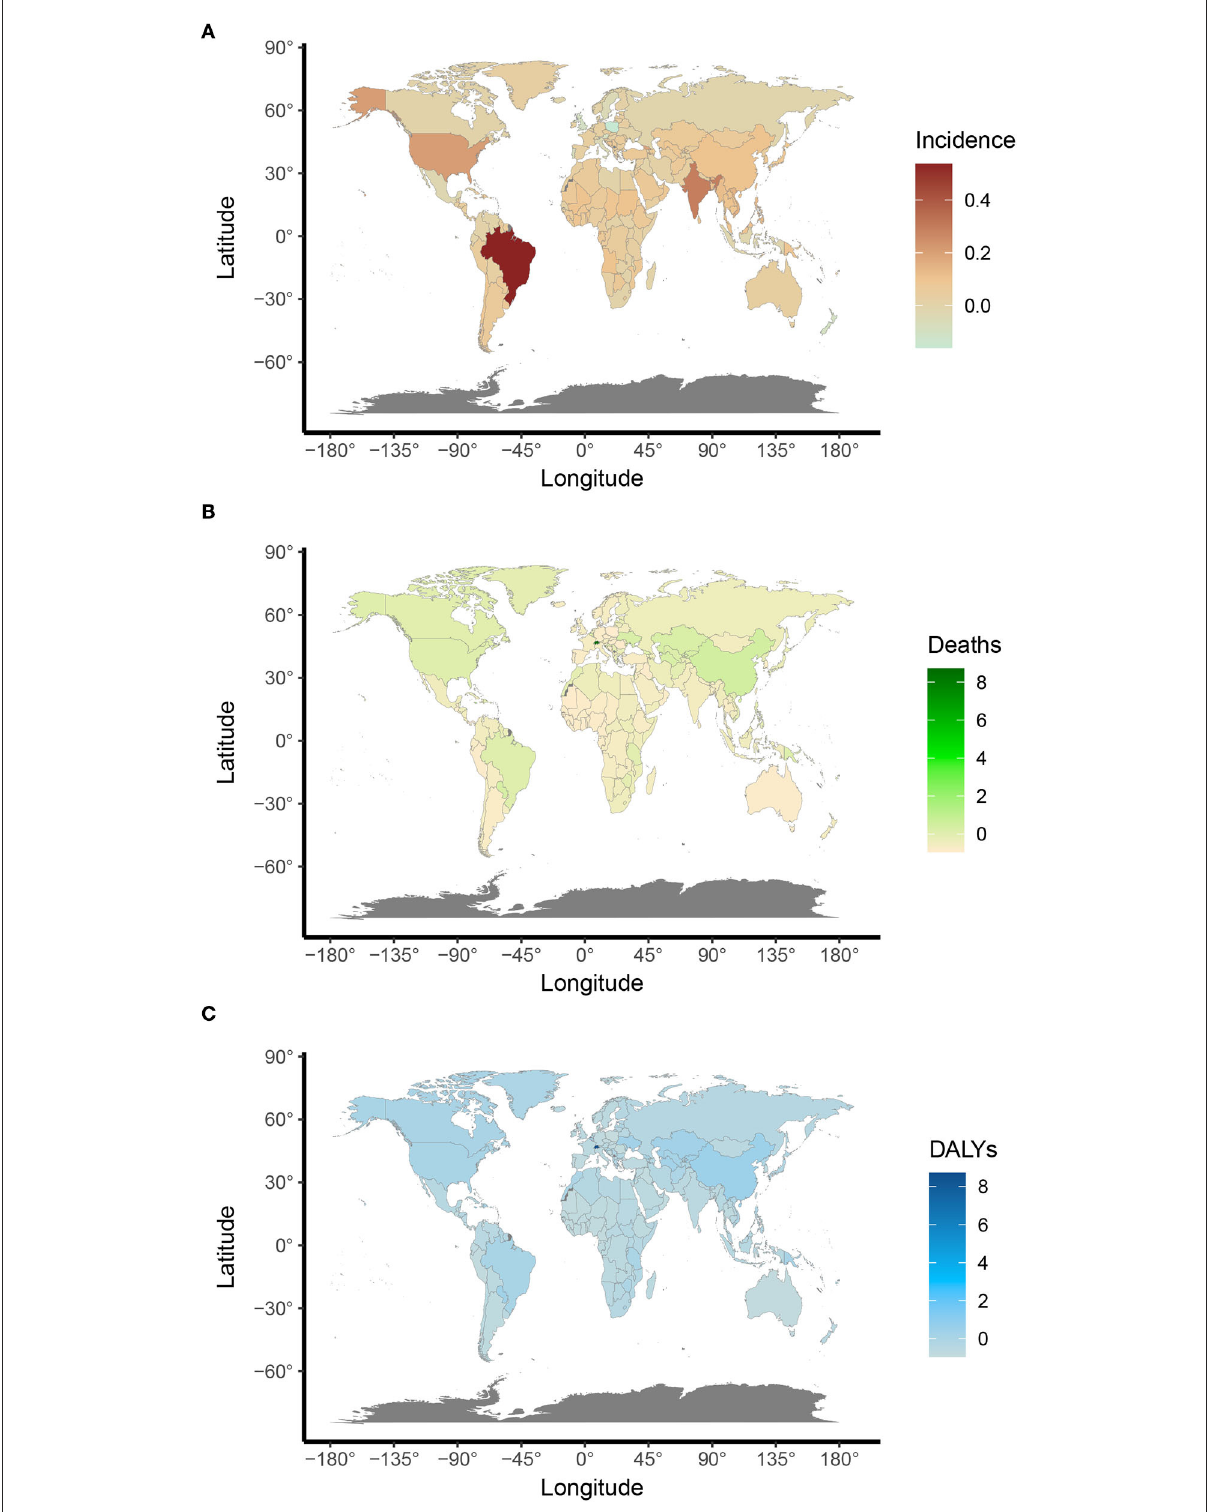
FIGURE5 Annual percent changes of age-standardized UFs ASR rates in 204 countries and territories between 1990 and 2019. (A) Age-standardized incidence; (B) Age-standardized death; and (C) Age-standardized